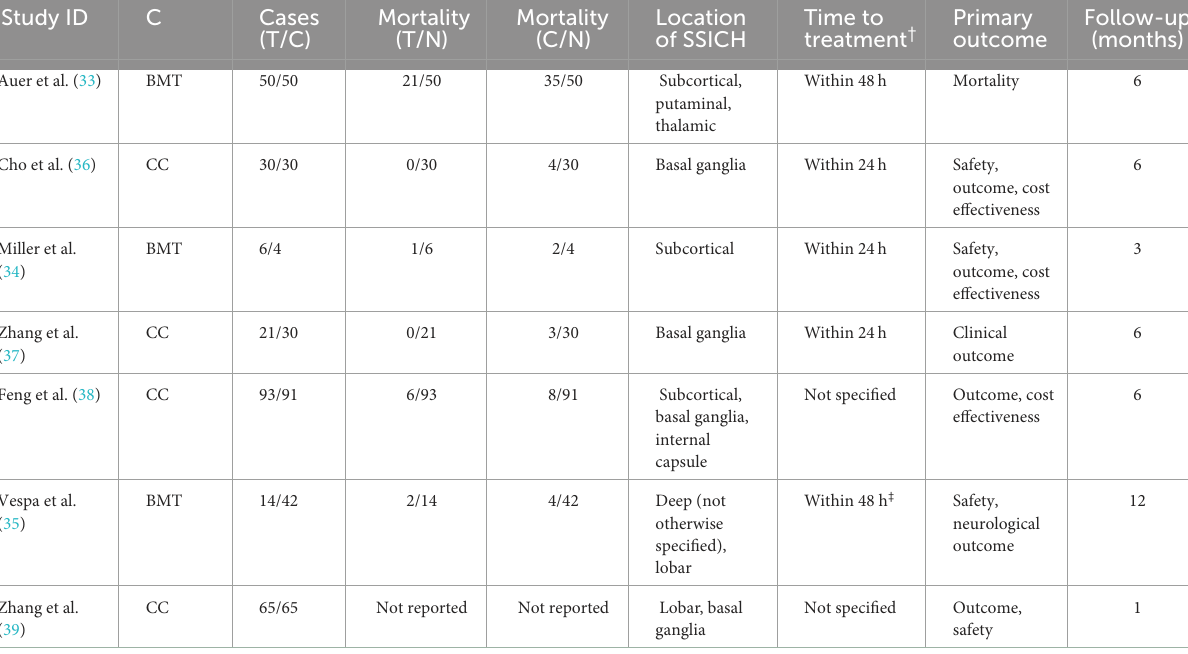
TABLE 1 Characteristics of the included studies. Study ID